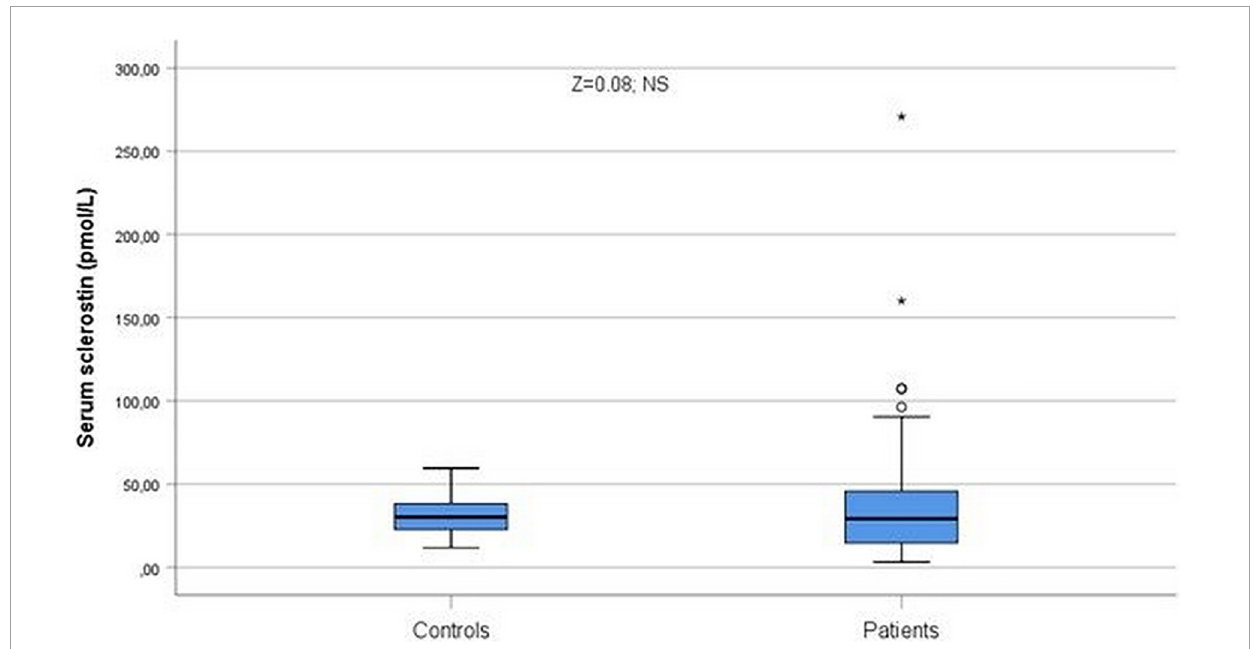
FIGURE2 Serum sclerostin levels were slightly, non-significantly higher among patients ( Z = 0.08; NS). ◦ Represent the outliers and *represent the extreme outliers.